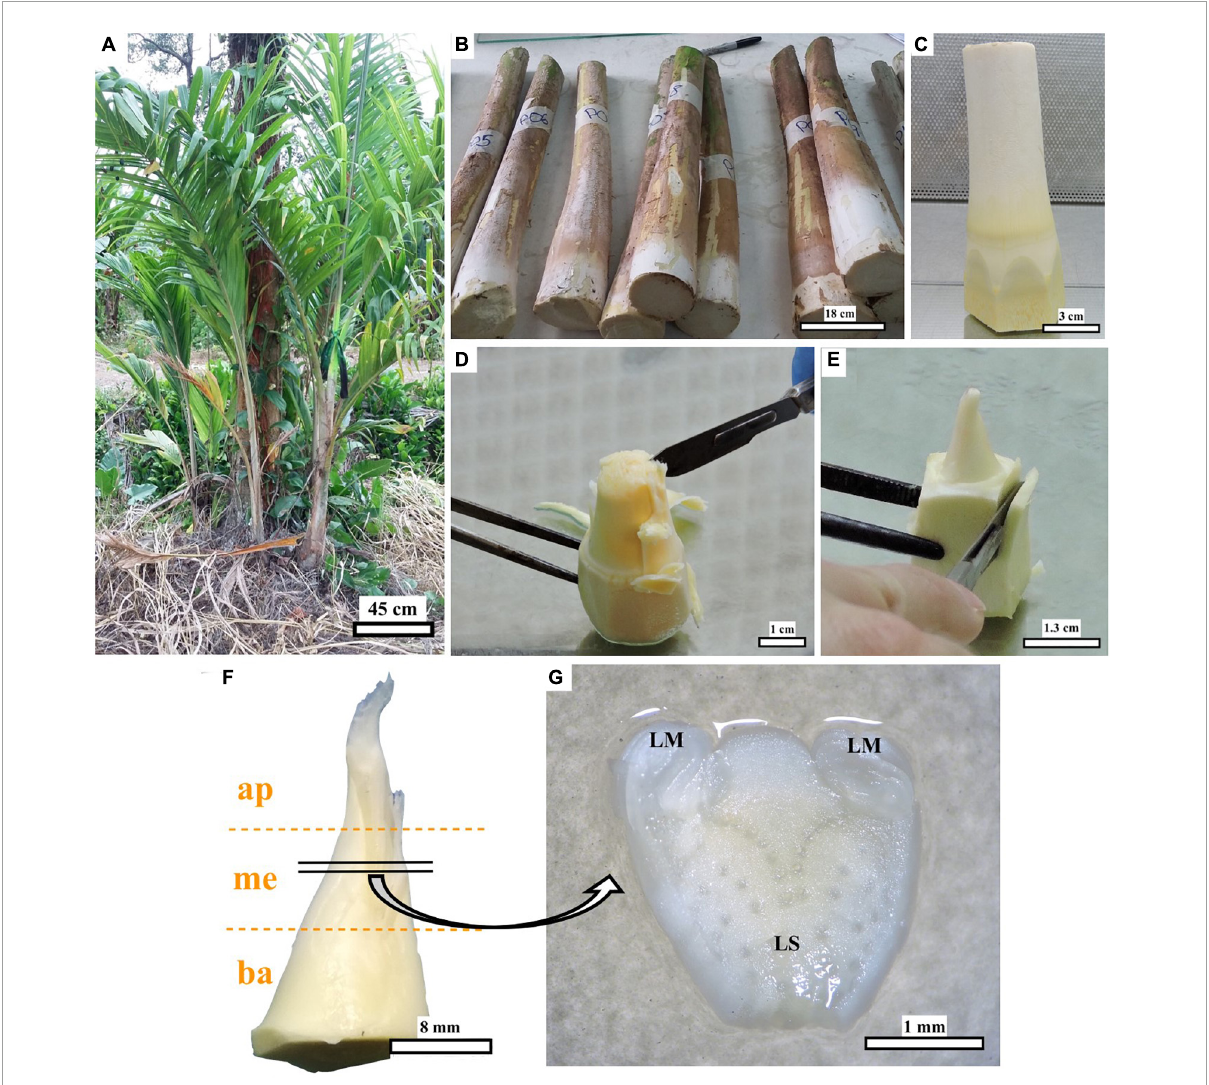
FIGURE1 Steps for peach palm explant preparation. Field material (A) , offshoots trimmed in the field (B) , explant pre-dissected for disinfection (C) , further dissection (D,E) , position of the explant sections [apical (ap)–medial (me)—basal (ba)] (F) , and transverse thin cell layer (explant dissected from each section) on the culture medium with leaf sheath (LS), and leaf sheath margins (LM) marked (G) . Black bars scale equivalent to 45 cm (A) , 18 cm (B) , 3 cm (C) , 1 cm (D) , 1.3 cm (E) , 8 mm (F), and 1 mm (G)